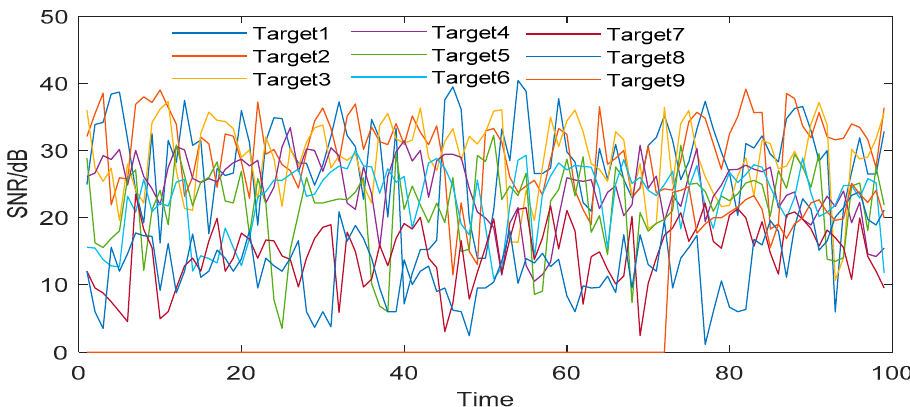
Sensors 2019 , 19 , x FOR PEER REVIEW